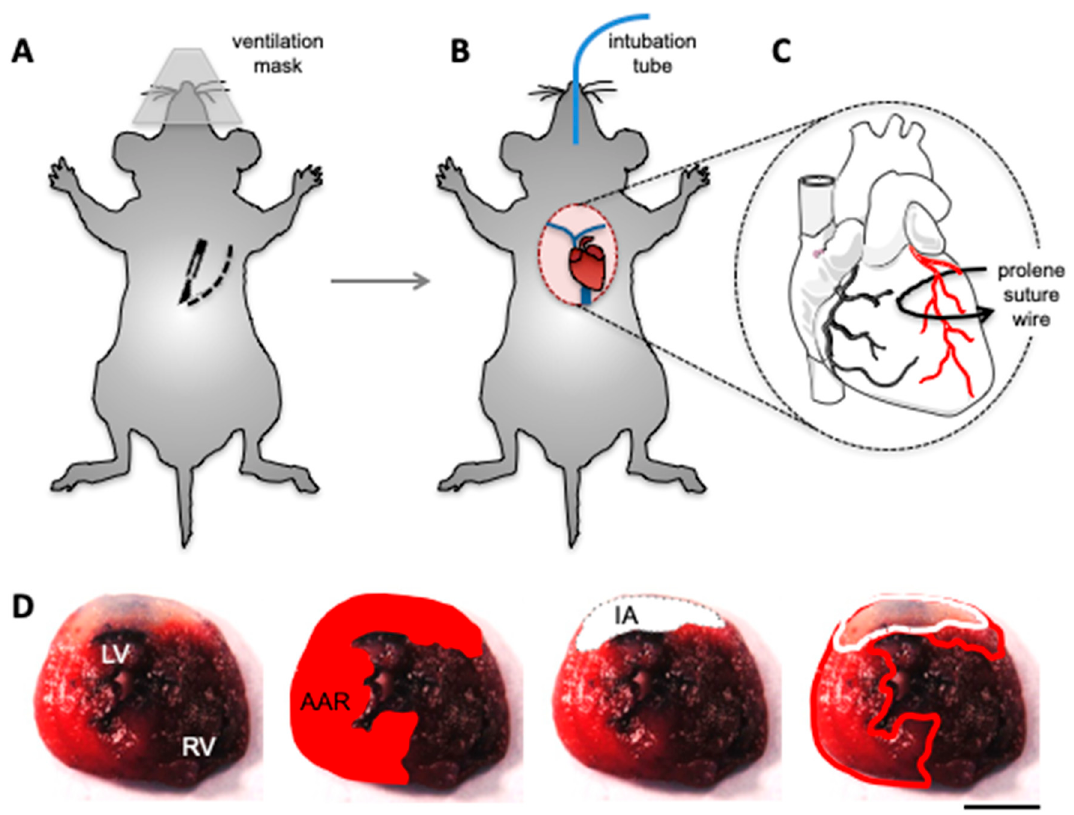
Figure 2. Schematic representation of the left anterior descending (LAD) ligation to induce in vivo ischemia/reperfusion (I/R) injury in mice. ( A ) After the induction of anesthesia, the mouse is placed in supine position and intubated. The chest is opened by performing a lateral incision of the left sternum side. ( B ) Separating the third and the fourth rib exposes the heart, allowing a prolene suture to be placed around the LAD in a snare that is then closed in order to induce ischemia. Reperfusion is performed 30 min later by releasing the snare. ( D ) In order to determine the area at risk (AAR), the LAD is re-occluded after reperfusion and Evans blue is injected intravenously. The dye stains all perfused tissues, including the right ventricle (RV) and part of the left ventricle (LV). The heart is sectioned into thin 1 mm slices and incubated with triphenyltetrazolium chloride (TTC) to determine the AAR (outlined in red) and the infarcted area (IA; outlined in white). Scale bare represents 50 μ m.